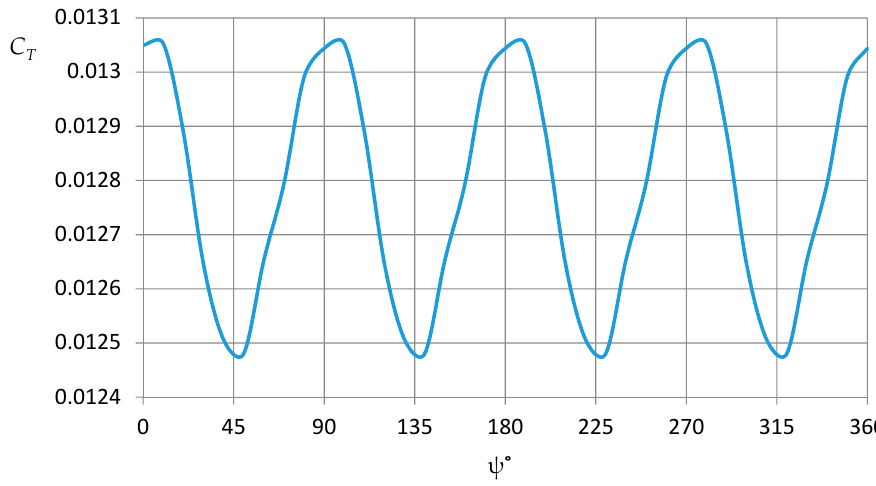
Figure 9. Main rotor thrust as function of the blade azimuth.